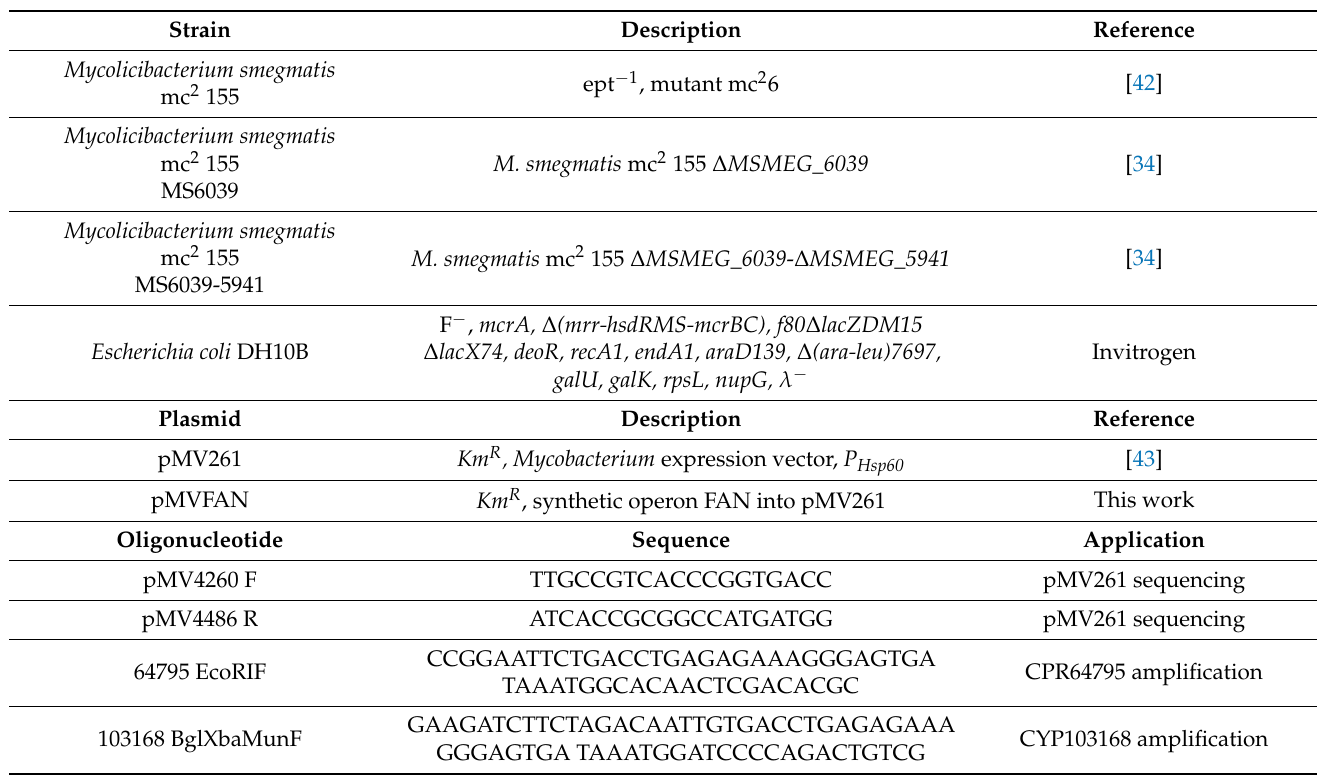
Table 1. Strains, plasmids and oligonucleotides used in this